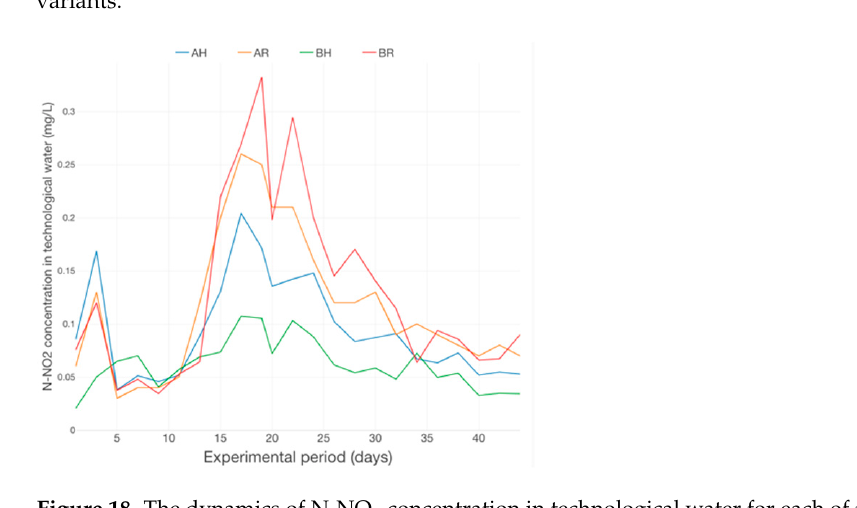
Figure 19. The dynamics of N-NO 3 concentration in technological water for each of the experimental variants. Figure 20. The dynamics of EC concentration in technological water for each of the experimental variants.